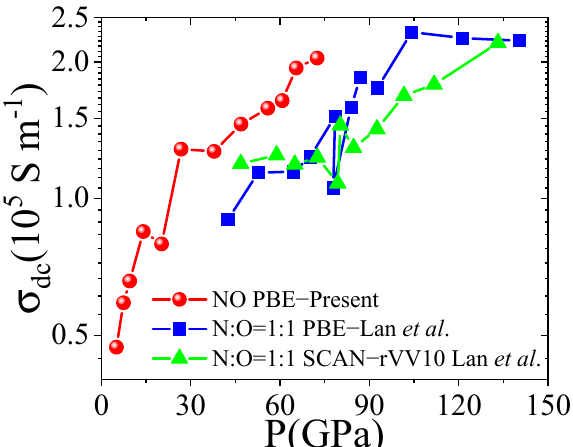
Figure 7. The direct current conductivities of NO along 2000 K isotherm, compared with the result of the nitrogen − oxygen 1:1 mixture at 2000 K calculated by Lan et al. [54].